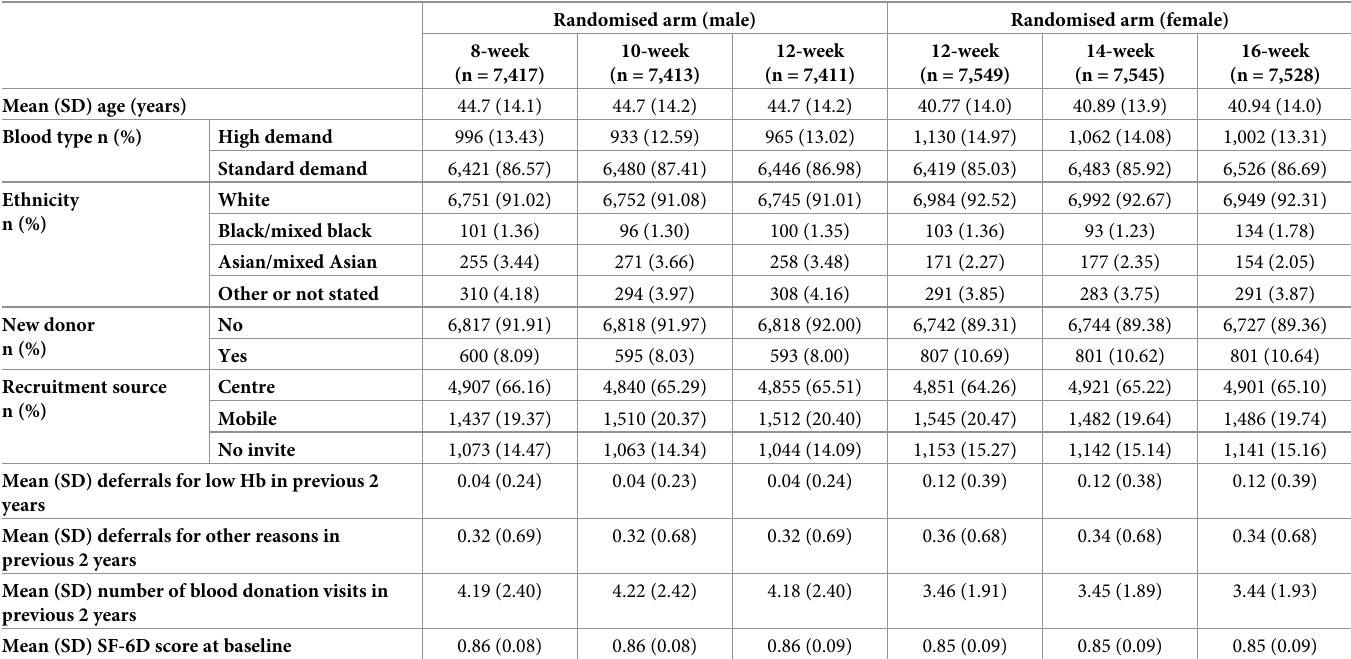
Table 1. Baseline characteristics, by randomised arm and gender.